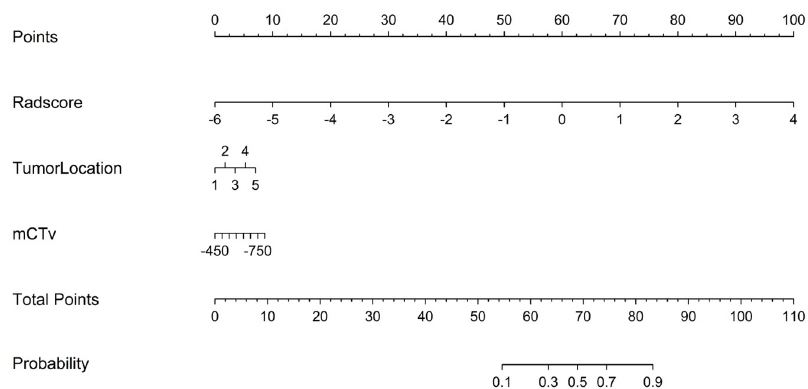
Fig 2. Nomogram of the combined model for the training cohort. The personalized predictive nomogram was constructed with tumor location, mean CT value of the whole nodule (mCTv), and rad_score. The “1”—“5” in the diagram represents the tumor location in the left lower lobe, left upper lobe, right lower lobe, right middle lobe, and right upper lobe.